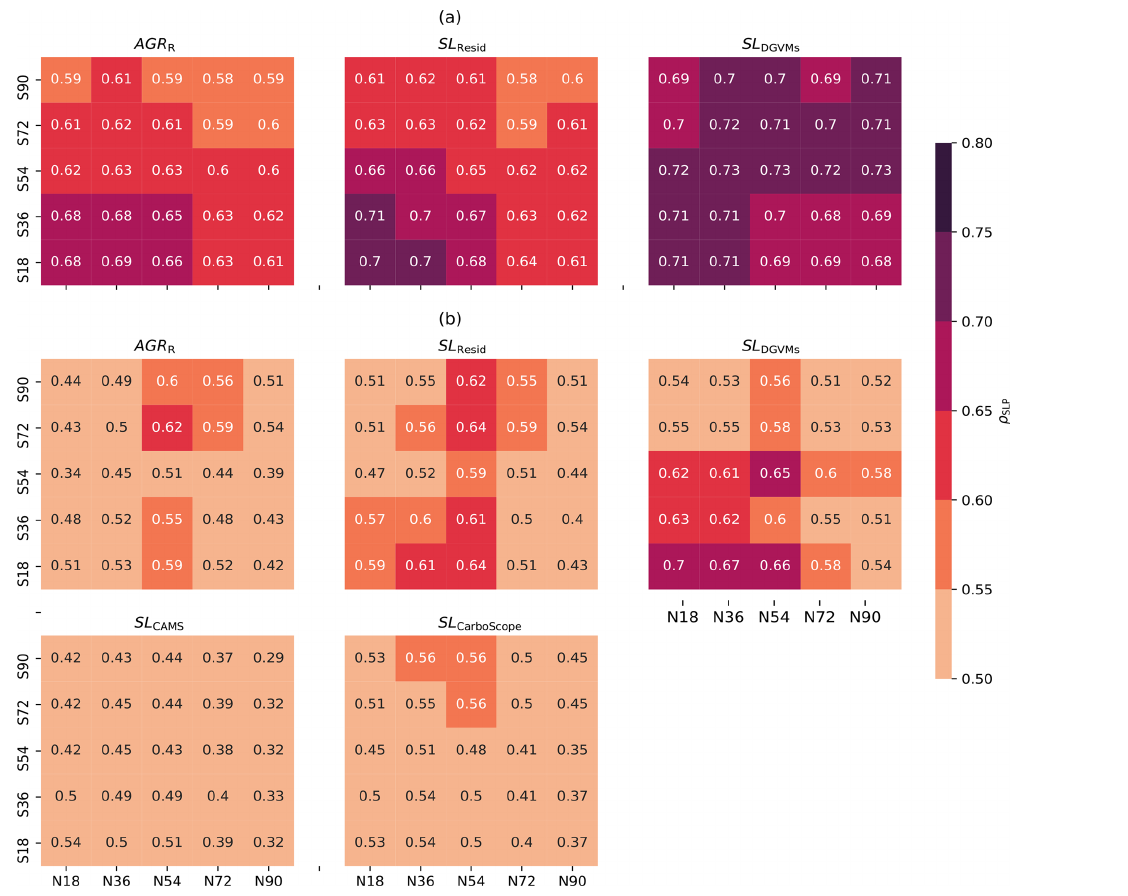
Figure A7. Heat map of ρ SLP with CO 2 time series over various SLP latitude domains in MAM. Each heat map contains 5 × 5 squares, and each square represents one specific domain of SLP. For example, the square 36 ◦ N–72 ◦ S is the domain of SLP extending from 36 ◦ N to 72 ◦ S. All latitudinal domains include the tropical area (18 ◦ N–18 ◦ S). The top right square thus represents global-scale SLP. The time series is from (a) 1959–2017 for AGR R , SL Resid , and SL DGVMs . (b) 1980–2017 included two more inversions: SL CAMS and SL CarboScope